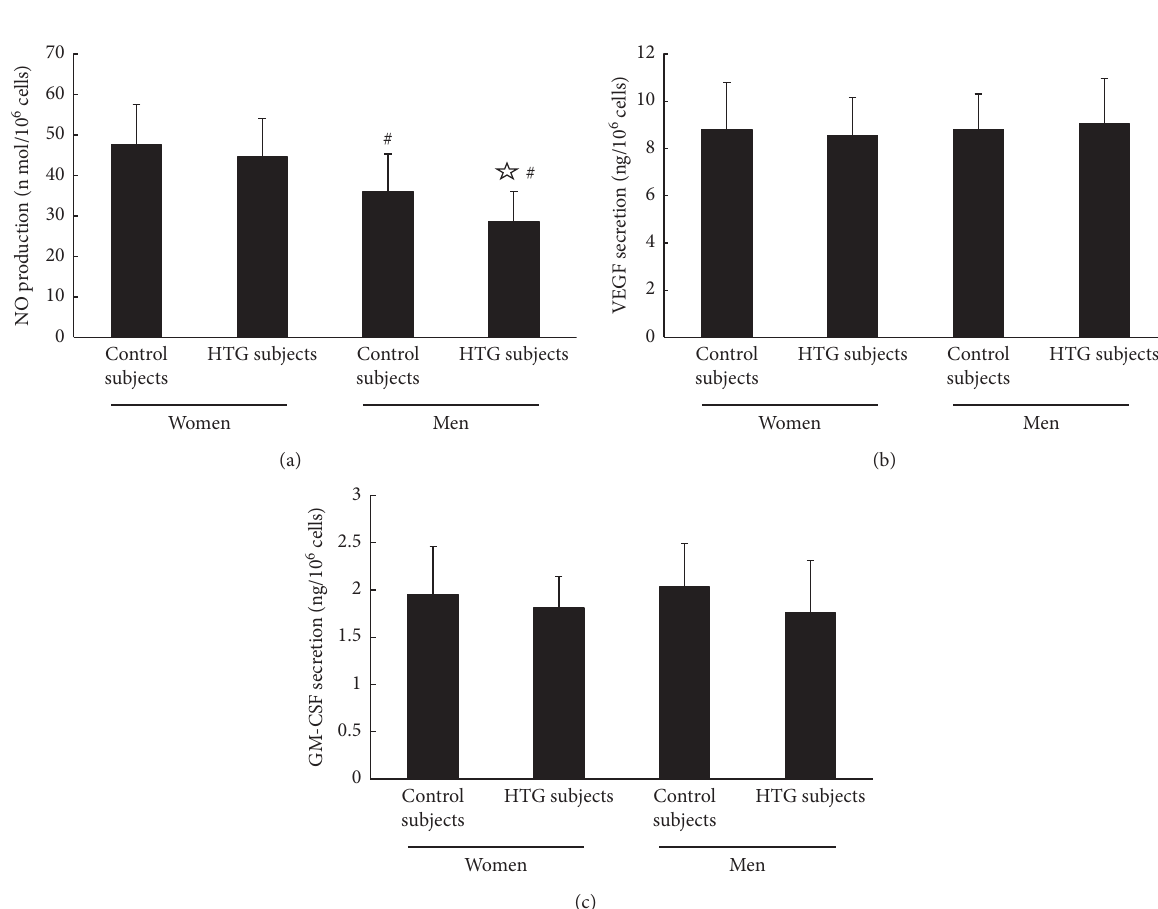
Figure 4: The levels of NO, VEGF, and GM-CSF secreted by cultured EPCs. (a) The level of NO produced by cultured EPCs of the normotriglyceridemic and hypertriglyceridemic men groups was remarkably lower than that of the premenopausal women groups. Besides, the secretion of NO from hypertriglyceridemic men was statically elevated compared with that from normotriglyceridemic men. Nev- ertheless, the level of NO in the EPCs cultural media of the hypertriglyceridemic premenopausal women was not significantly different from that of the normotriglyceridemic premenopausal women). (b) and (c) There was no obvious difference in VEGF or GM-CSF secretion between four groups.